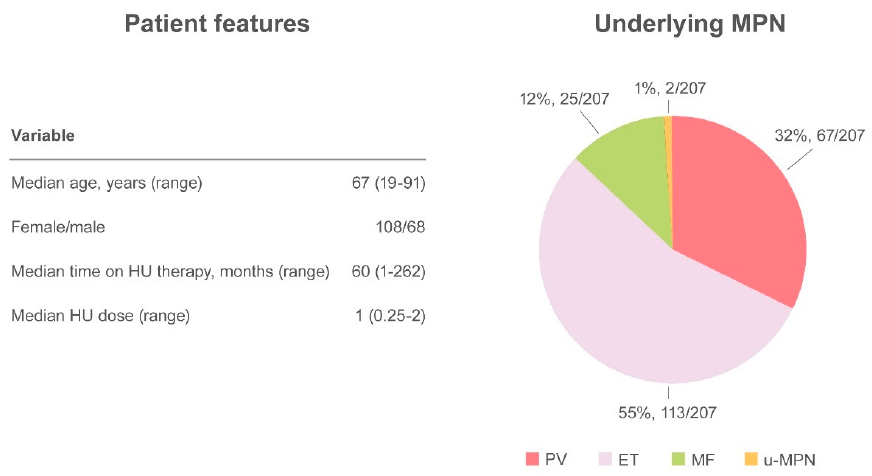
Figure 3. Summary of cutaneous ulcers as an adverse event.